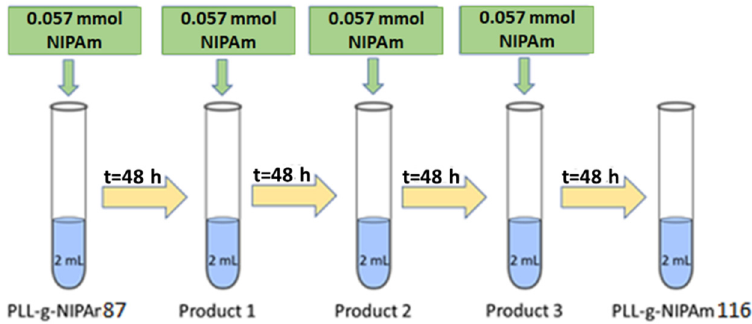
Scheme 2. Schematic representation of the “in situ” enrichment of PLL with NIPAm.